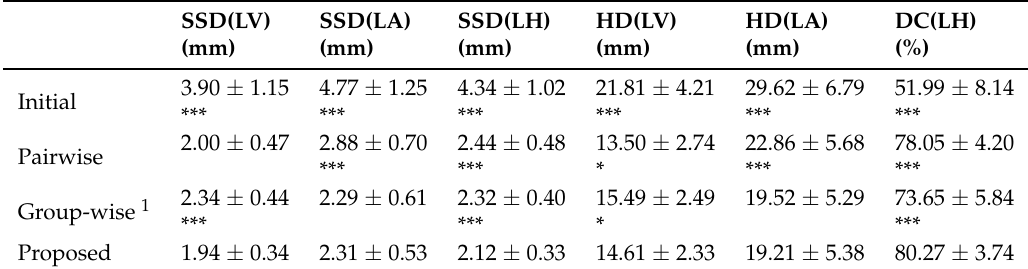
Table 1. Segmentation result comparison according to correspondence construction methods. This result is calculated with 35 cases under six-fold